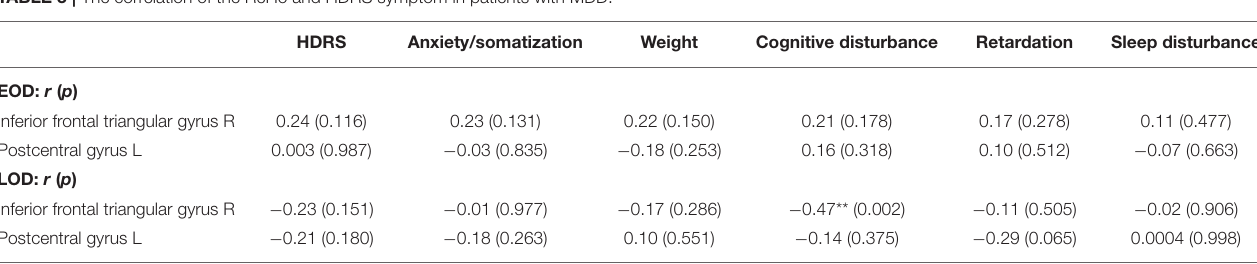
TABLE 3 | The correlation of the ReHo and HDRS symptom in patients with MDD. HDRS Anxiety/somatization Weight Cognitive disturbance Retardation Sleep